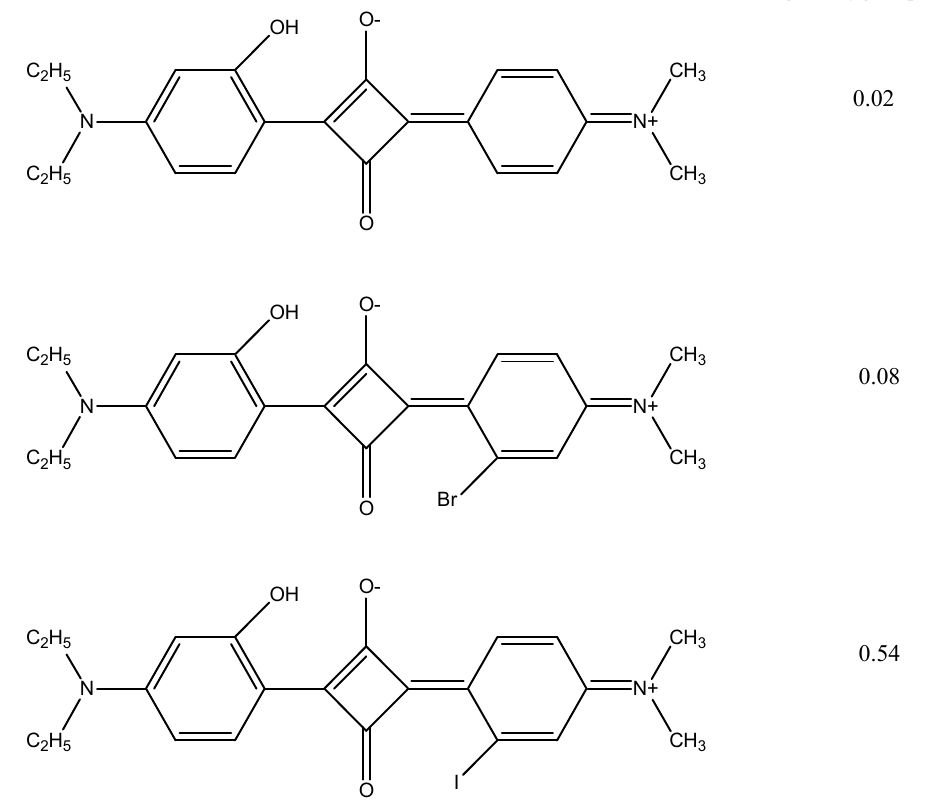
Figure 23. Iodinated squaraine giving enhanced 1 O 2 quantum